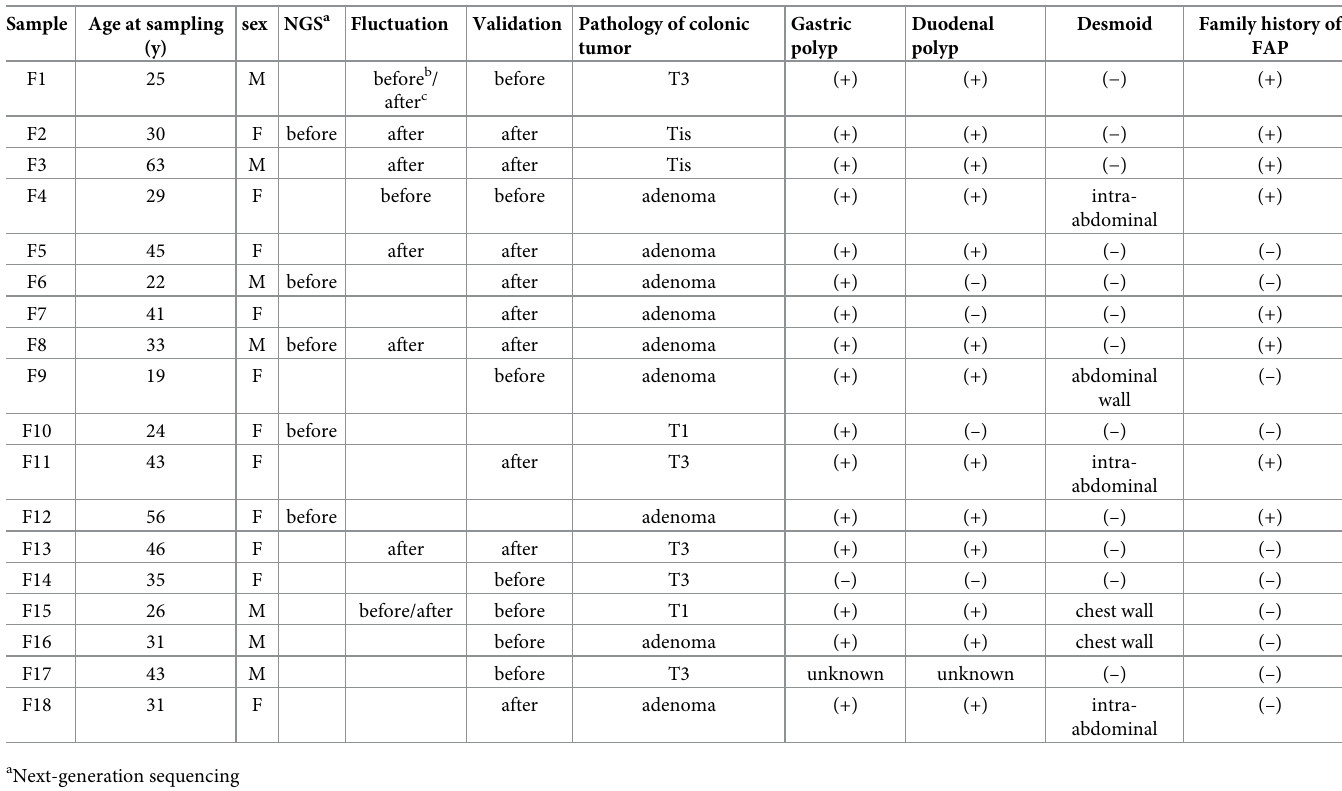
Table 1. Patients with Familial Adenomatous Polyposis (FAP) used for plasma microRNA analysis in the current